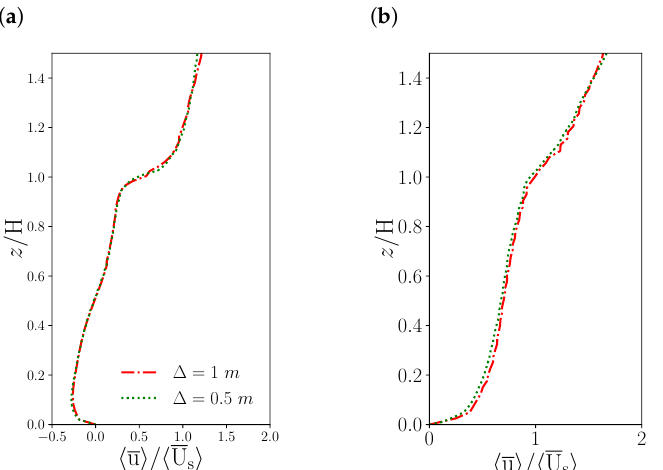
Figure A5. Vertical profiles of temporally and spatially averaged normalised velocity for two different resolutions. ( a ) a 2-D street canyon ( AR = 1); ( b ) a realistic canyon (Figure 1d). Finer grid sizes ( ∆ = 0.5 m) are represented by green dotted lines; coarser grid sizes ( ∆ = 1 m) are indicated by red dash-dotted lines.